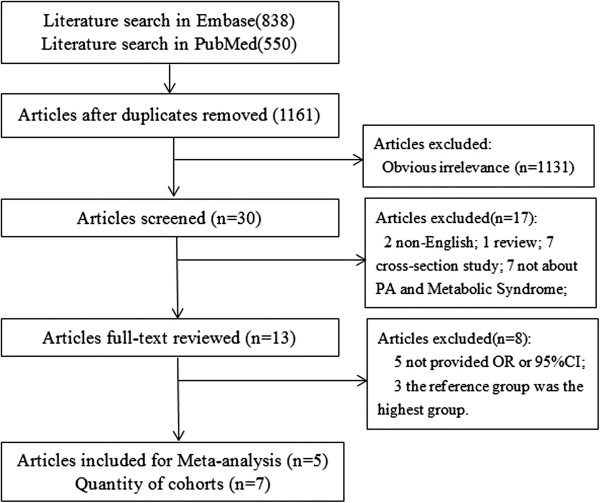
Literature search and study selection. CI, confidence interval; OR, odds ratio; PA, physical activity.